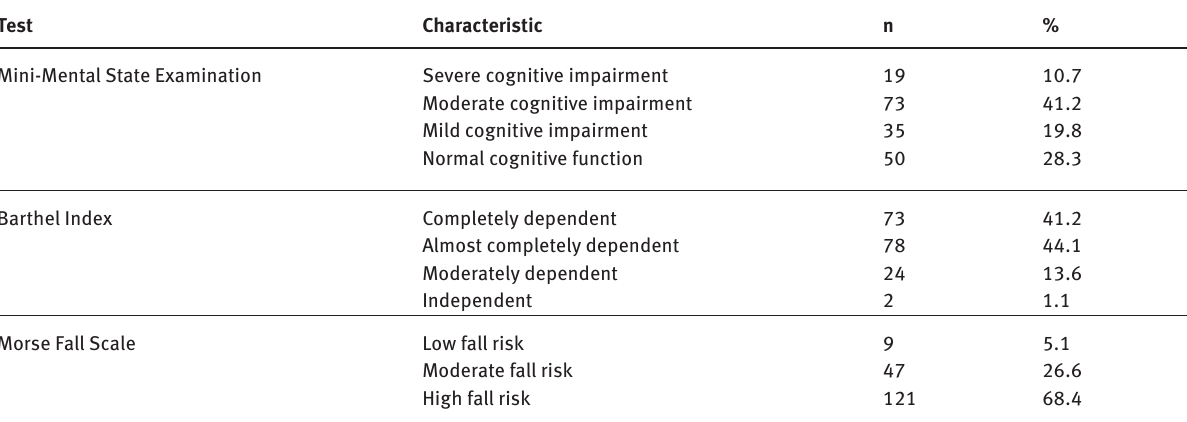
Table 2: Distribution of the respondents according to the results of the Mini-Mental State Examination, Barthel Index and Morse Fall Scale (n = 177)